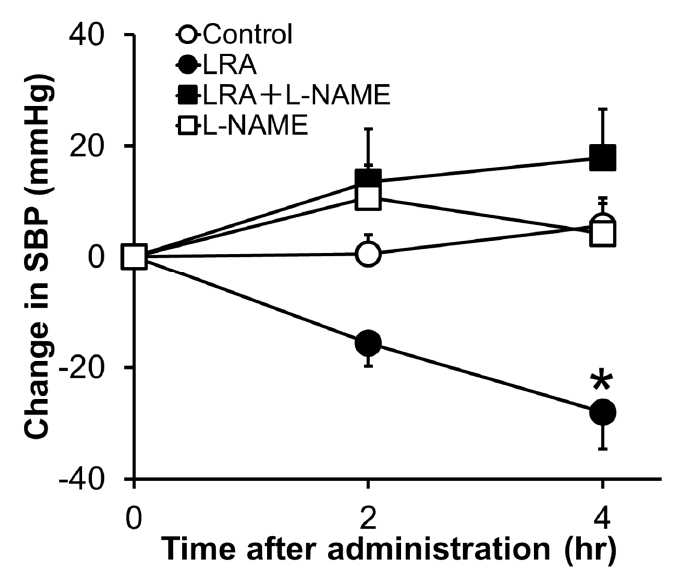
Figure 2. Effects of L-NAME, an NOS inhibitor, on the anti-hypertensive activity of LRA after oral administration in SHRs. L-NAME (20 mg / kg) was administrated just before the oral administration of LRA (1.0 mg / kg) or saline. The Y-axis represents the change in SBP from the beginning of the examination. Values are the mean ± SEM (N = 8–10). * p < 0.05, vs. control group. These figures were modified and quoted from those previously reported by the author [27]. L-NAME, N(G)-nitro-L-arginine methyl